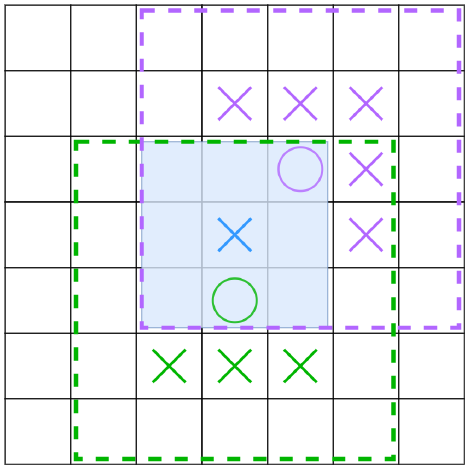
Figure 3. Diagram representing the possible cluster centre positions overlapping with the central cluster in a 7 7 window. The maxima positions are marked with crosses and the two overlap cells × that need to be predicted are marked with a